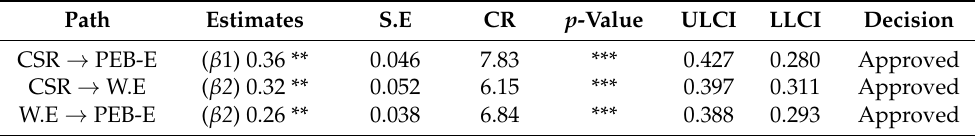
Table 5. The results for hypotheses testing (H1, H2 and H3). Path Estimates